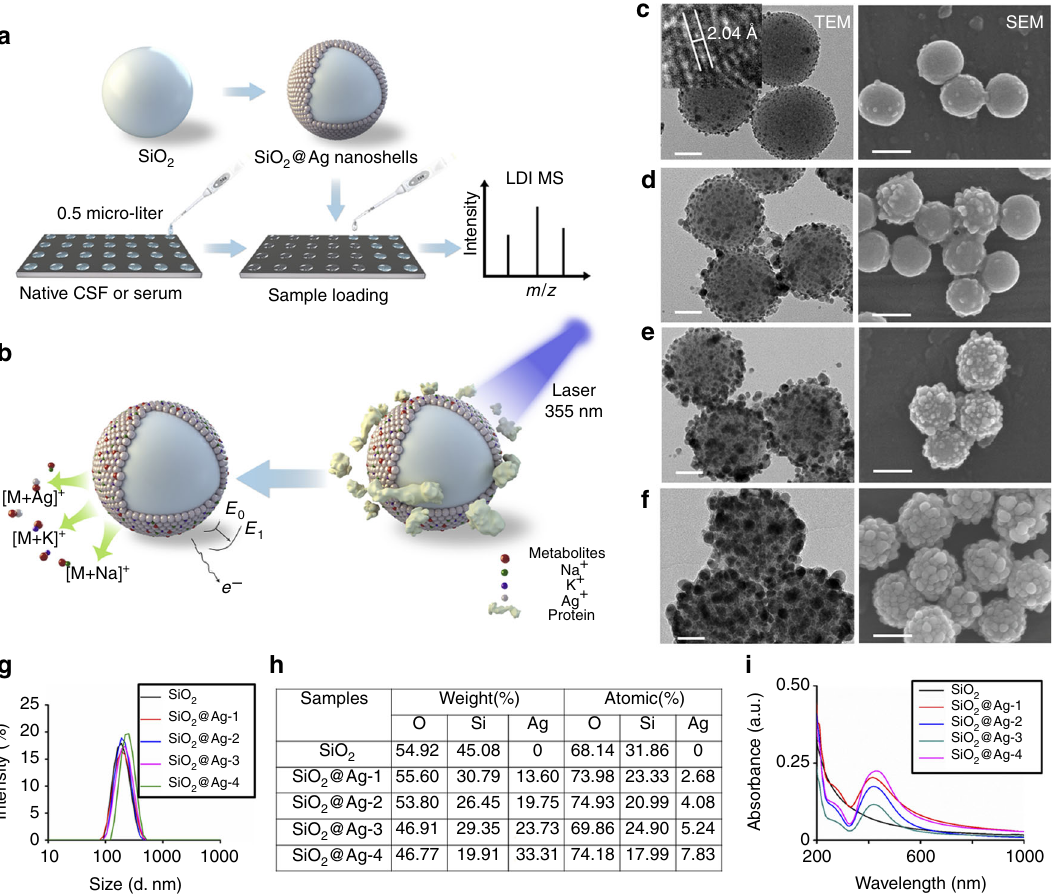
Fig. 1 Schematic work fl ow and material characterization. Schematic diagrams of a experimental work fl ow and b LDI MS process using SiO 2 @Ag nanoshells as matrix. Electron micrograph images of c SiO 2 @Ag-1, d SiO 2 @Ag-2, e SiO 2 @Ag-3, and f SiO 2 @Ag-4, including TEM images of particles and HRTEM showing silver crystal lattice ( inset of c ), and SEM images of particles. g average size distributions of SiO 2 and SiO 2 @Ag particles in water by DLS; h elementary composition analysis of SiO 2 and SiO 2 @Ag particles; i UV-Vis absorption spectra of SiO 2 and SiO 2 @Ag particles. Scale bars : 50 nm (TEM);